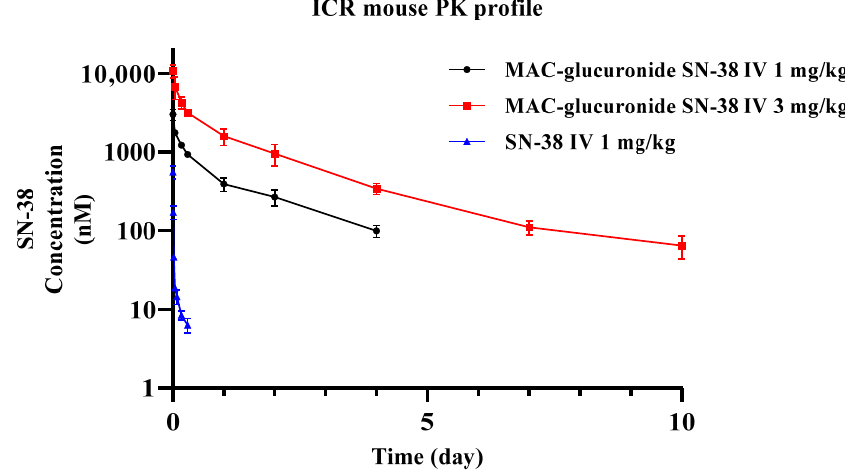
Figure 7. Pharmacokinetic profiles of SN-38 at 1 mg/kg and albumin conjugated SN-38 at 1 mg/kg and 3 mg/kg MAC glucuronide phenol linked SN-38 after Intravenous administration. Table 3. Pharmacokinetic parameters of SN-38 at 1 mg/kg and albumin conjugated SN-38 at 1 mg/kg and 3 mg/kg of MAC glucuronide phenol linked SN-38 (as an equivalent dose of SN-38, 0.36 and 1.08 mg/kg respectively) after intravenous administration.